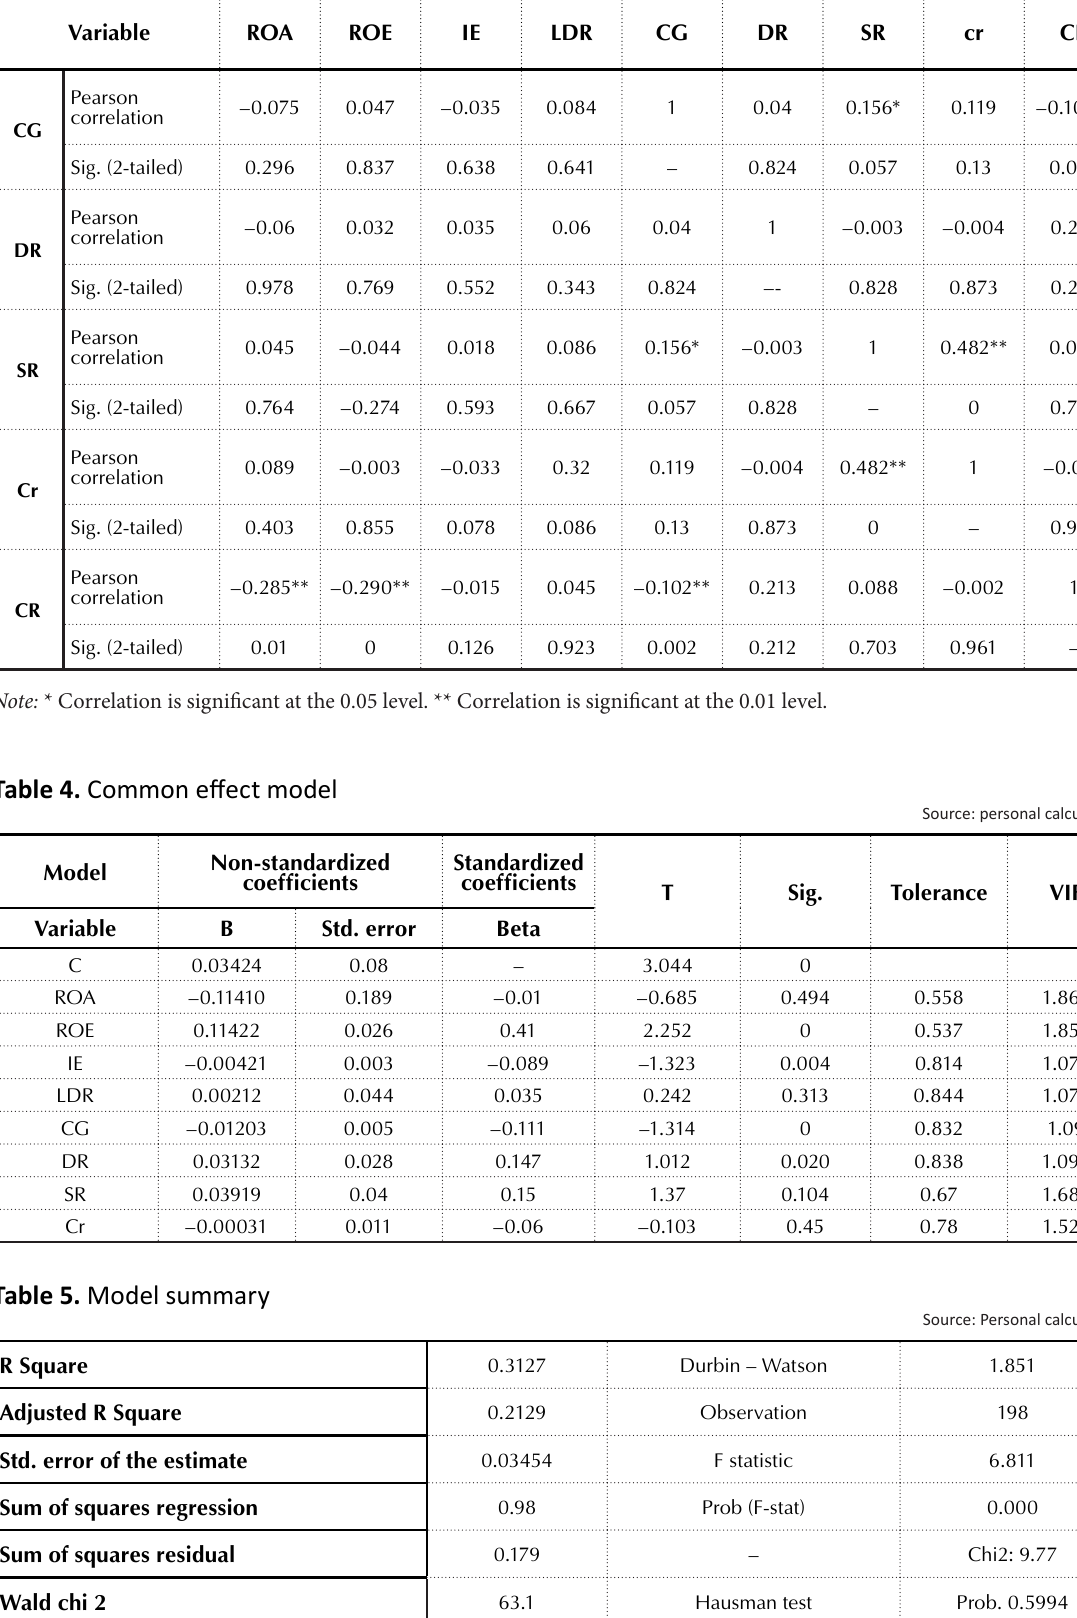
Table 3 (cont.). Correlation matrix of bank specific variables